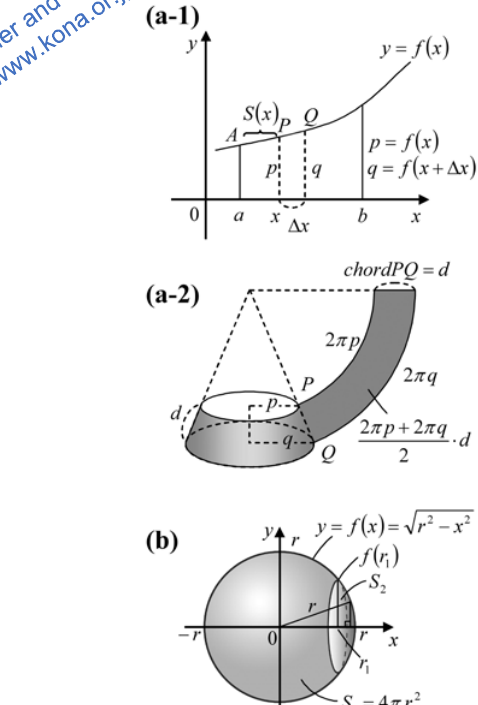
Fig. 8 Calculation of partial surface area of a